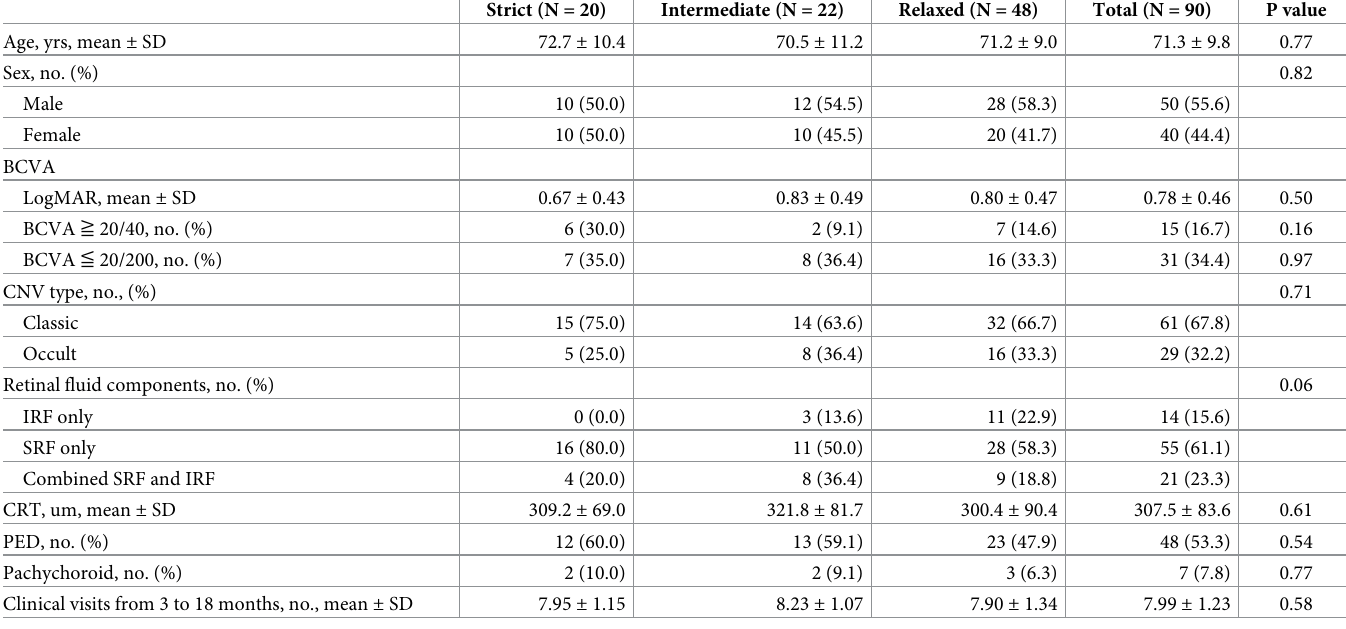
Table 1. Baseline demographic data and clinical characteristics.